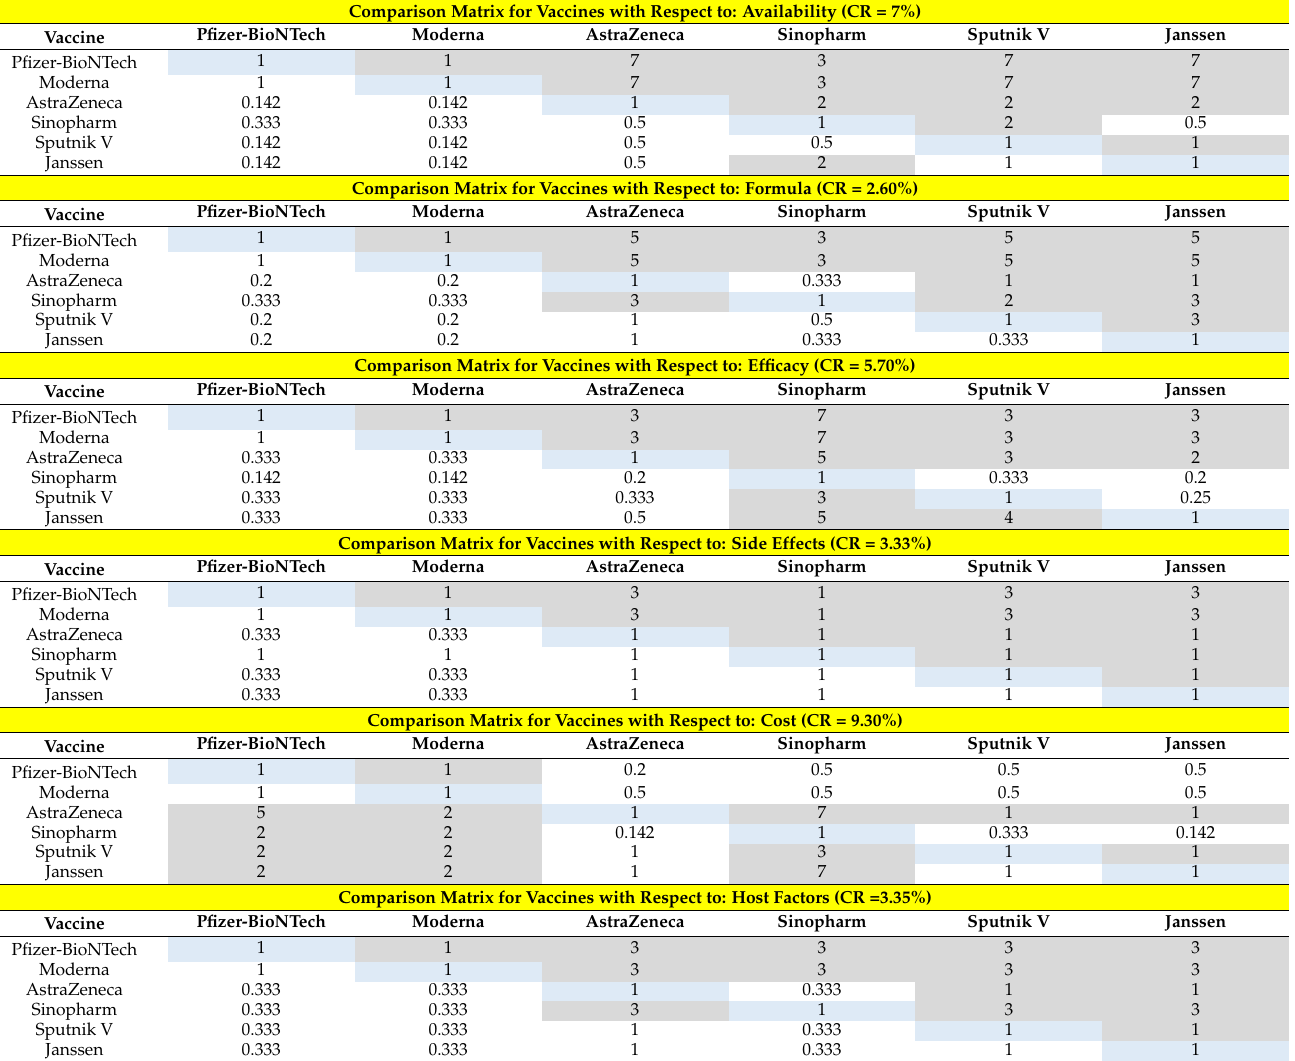
Table 3. Comparison matrices of model inputs for vaccines (Respondent